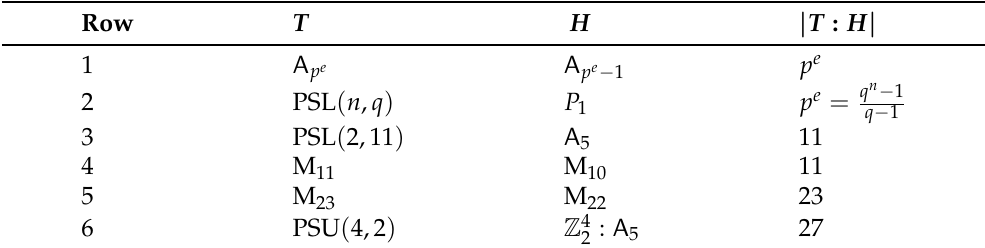
Table 2. Non-abelian simple group containing subgroups with index p e .